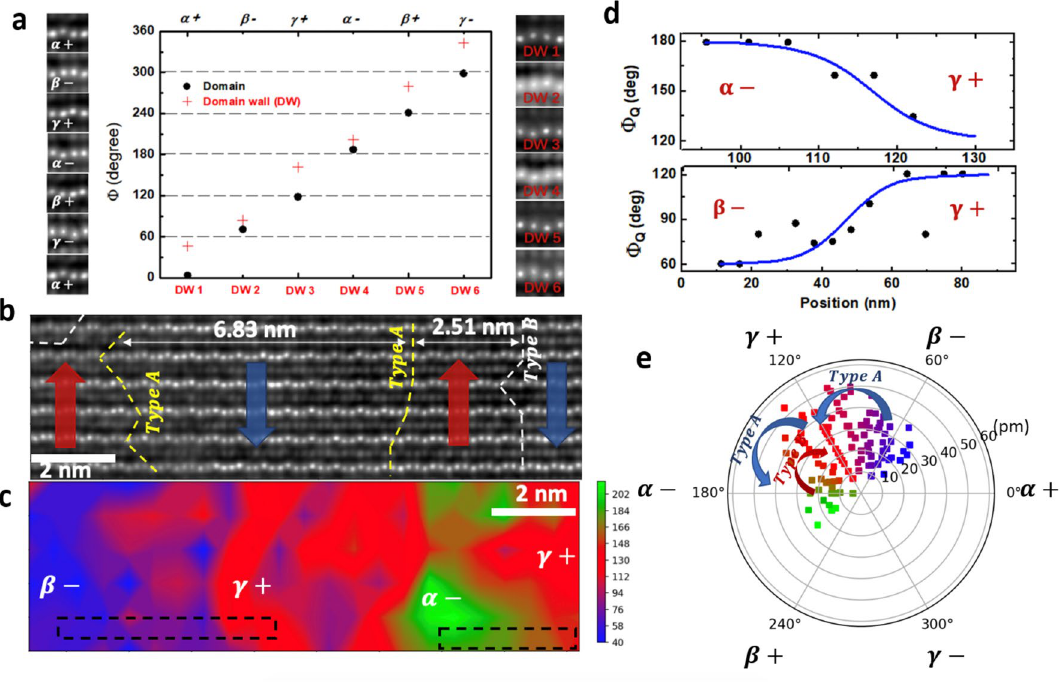
Figure 4. The distribution of FE domain walls and structural order parameters in h-YbFeO 3 film with small crystallites. ( a ) Characteristic four-atom patterns and φ Q distribution for individual FE domains and domain walls based on the HADDF images. ( b ) Cross-section HADDF-STEM of multidomain area in h-YbFeO 3 films along the [100] zone axis. ( c ) The spatial distribution of φ Q corresponding to ( b ). ( d ) Line profiles of α − | γ + and β − | γ + FE domain walls in dashed boxes of ( c ). ( e ) The pole figure of the structural order parameters (Q, φ Q ) distribution for the FE multidomain area, based on the HADDF image of ( b